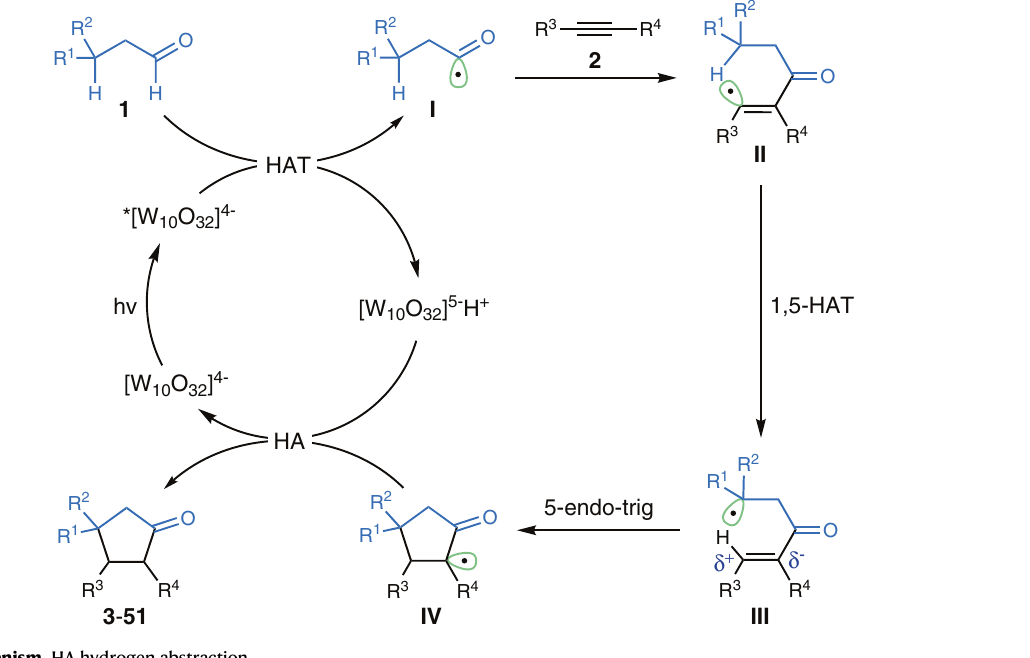
Fig. 5 | Proposed mechanism. HA hydrogen